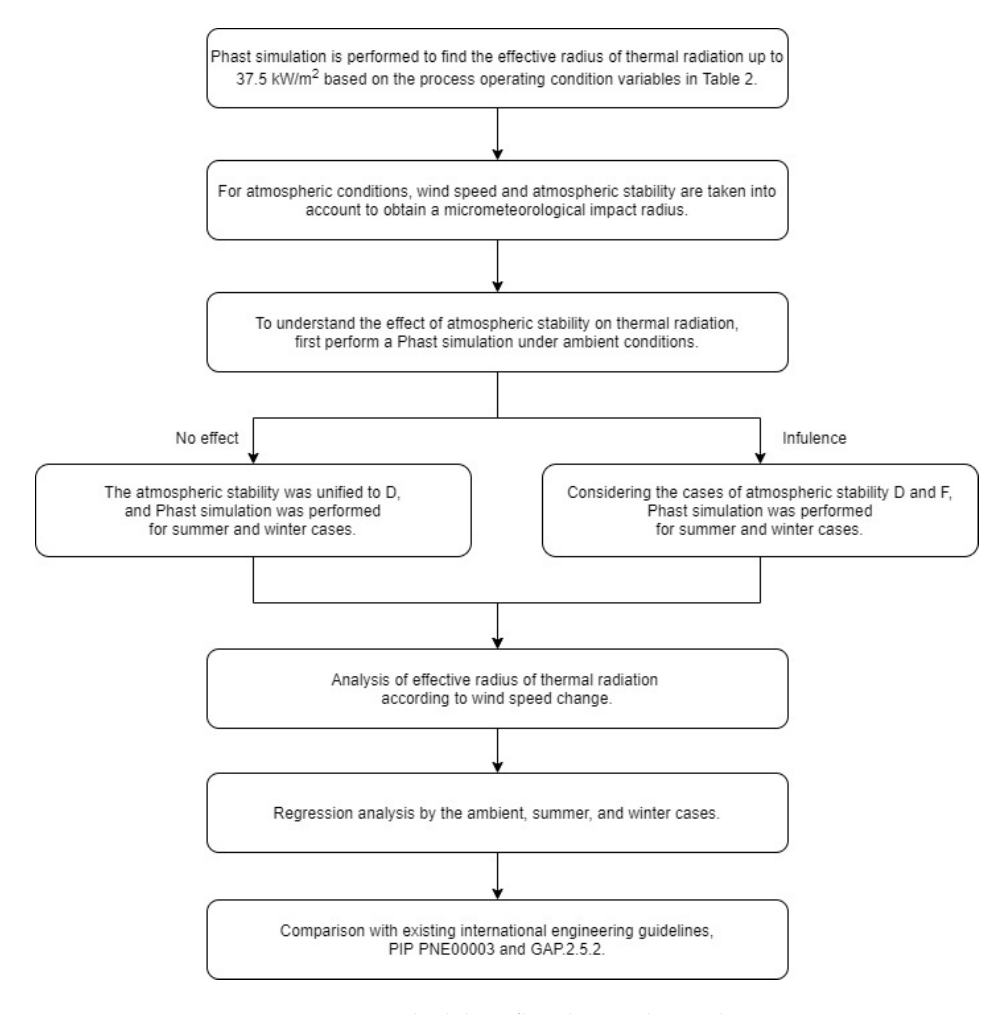
Figure 1. Methodology flowchart in this study.